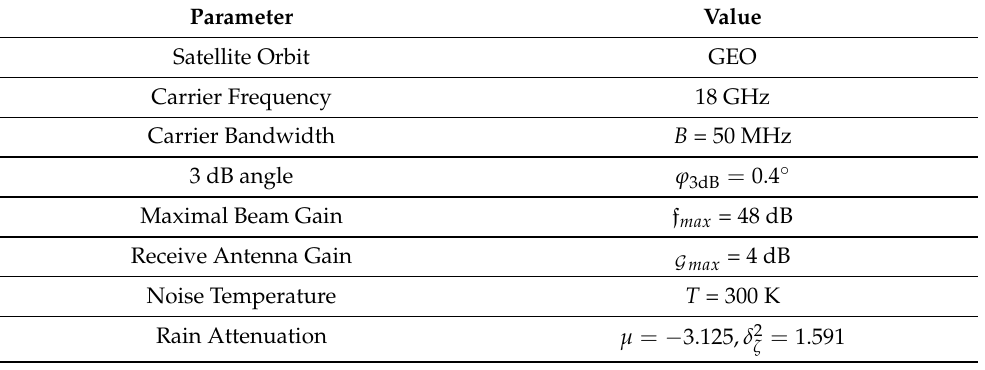
Table 1. System parameters.